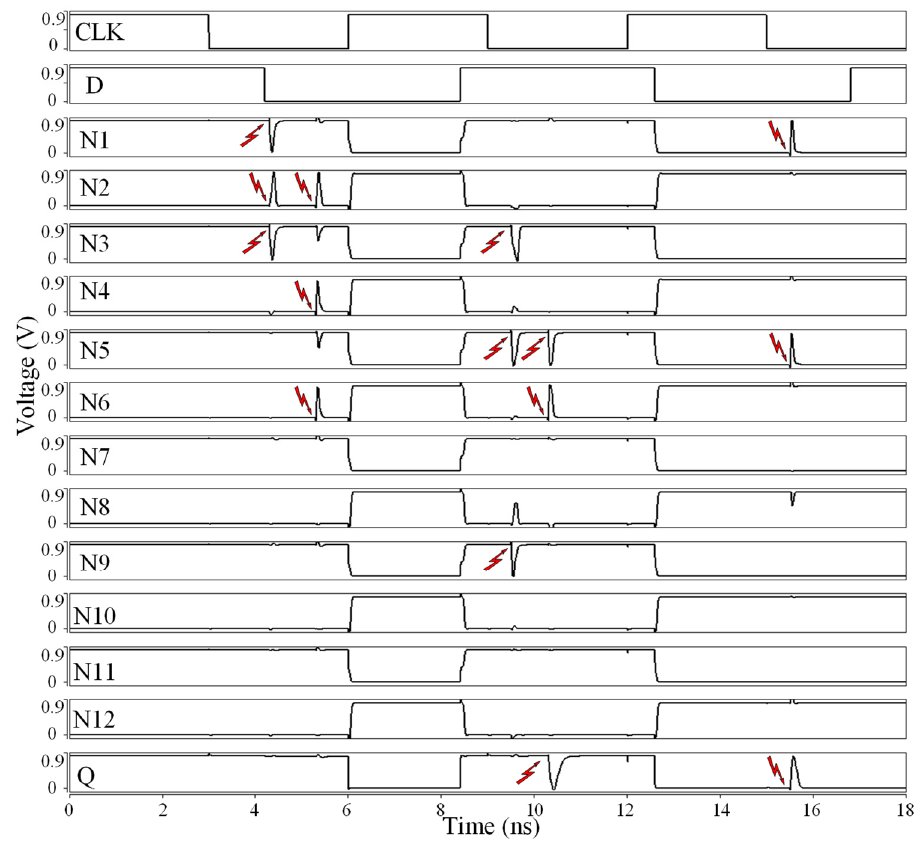
Figure 12. Simulation for TNU injections of HLTNURL latch.